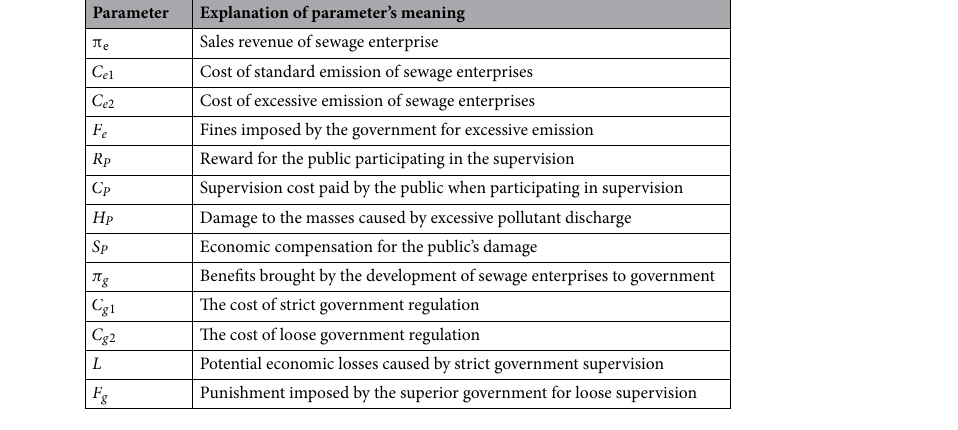
Table 1. Relevant parameters of the evolutionary game